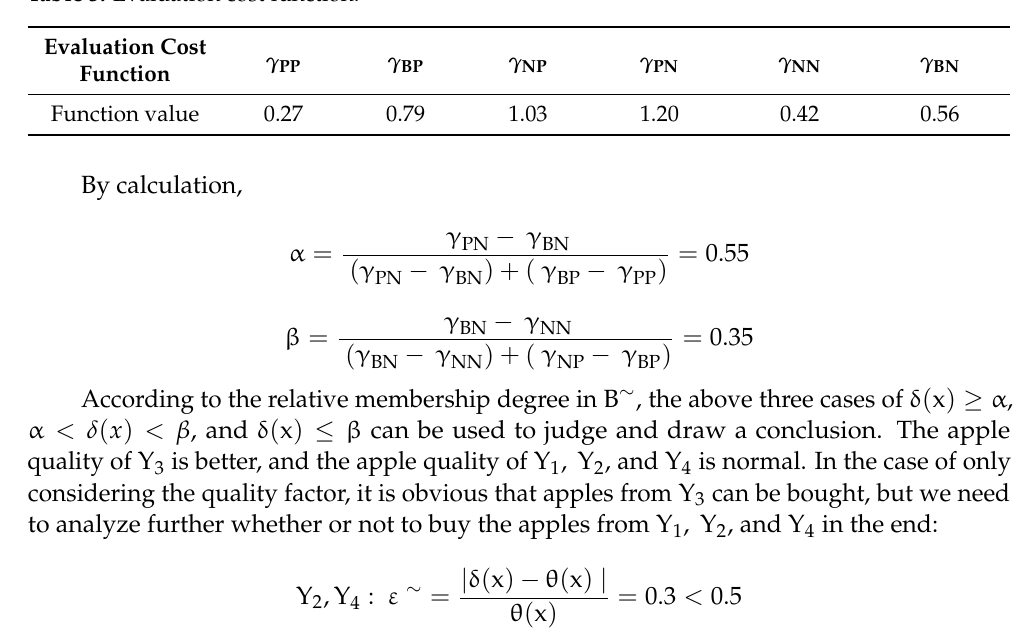
Table 3. Evaluation cost